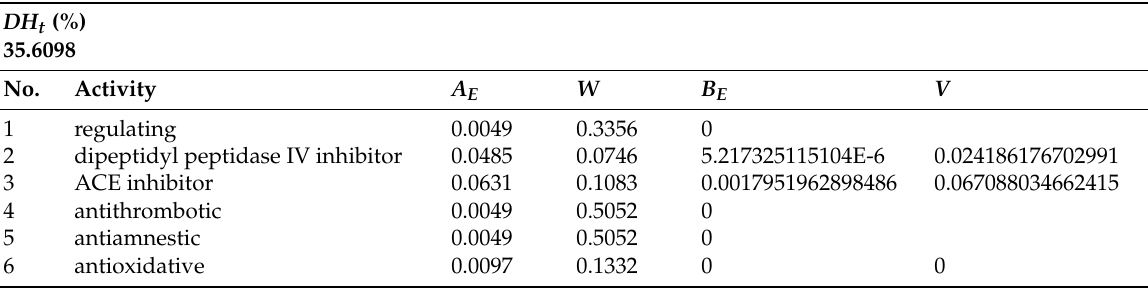
Table A18. A E , DH t , W , B E and V values from RubisCO of Halophila stipulacea . In silico enzymatic cleavage was carried out by Chymotrypsin.